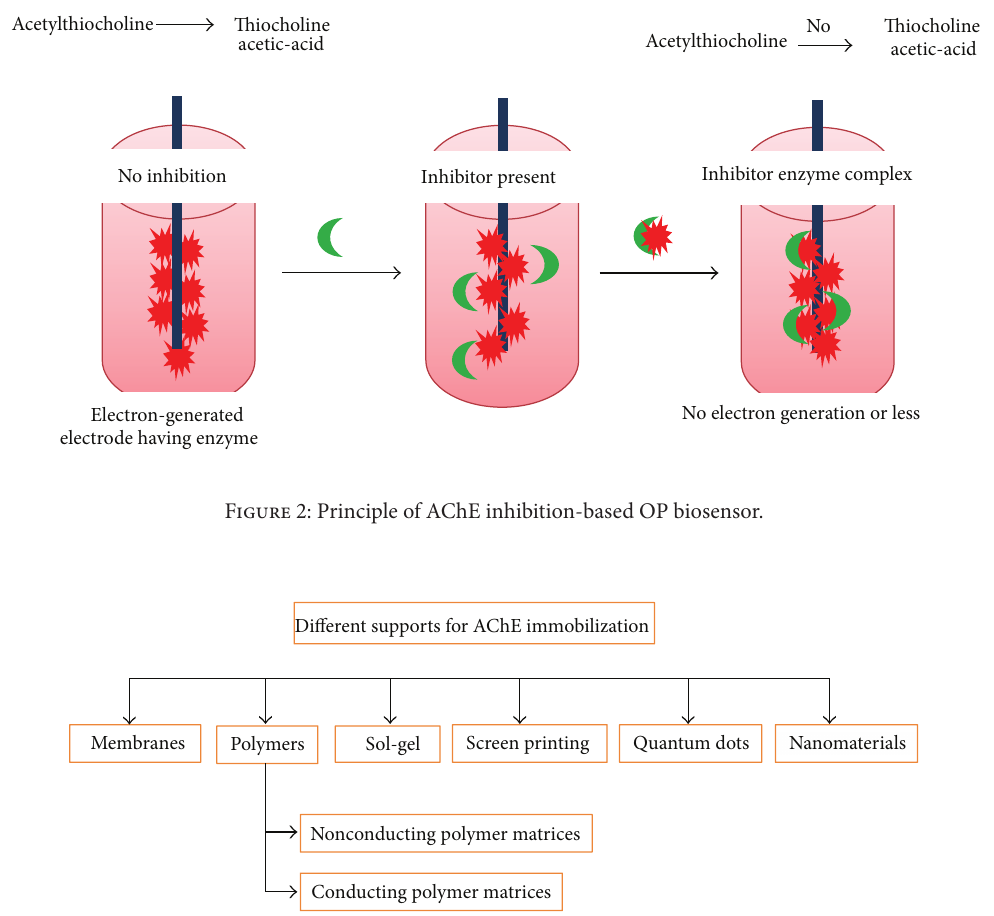
Figure 3: Different supports available for fabrication of working